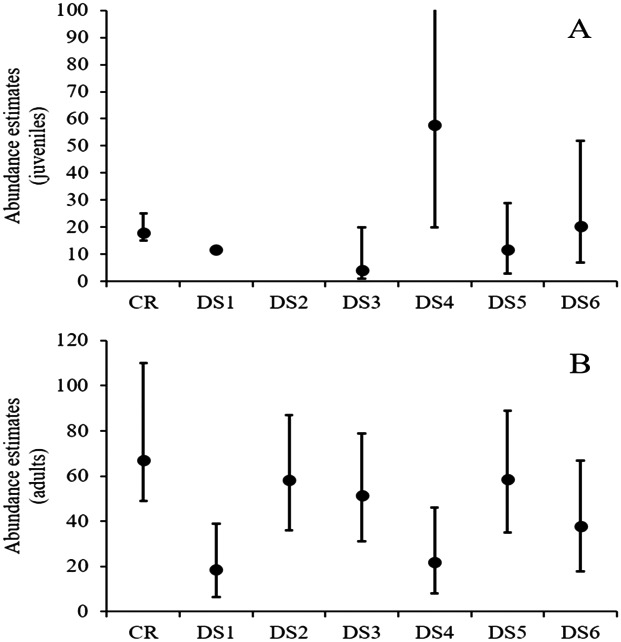
Rio Grande cooter abundance estimates.Derived Rio Grande cooter (Pseudemys gorzugi) abundance estimates for juveniles (turtles <65 mm straight carapace length; (A) and adults (including subadult turtles larger than juveniles; (B) with credible and confidence intervals using capture–recapture (CR) and six distance sampling events (DS1–DS6) at site 1 along the Black River, New Mexico. Note that in the case of juvenile turtles, for the first distance survey the data could not be converted and for the second distance survey event the data were too sparse to estimate abundance.